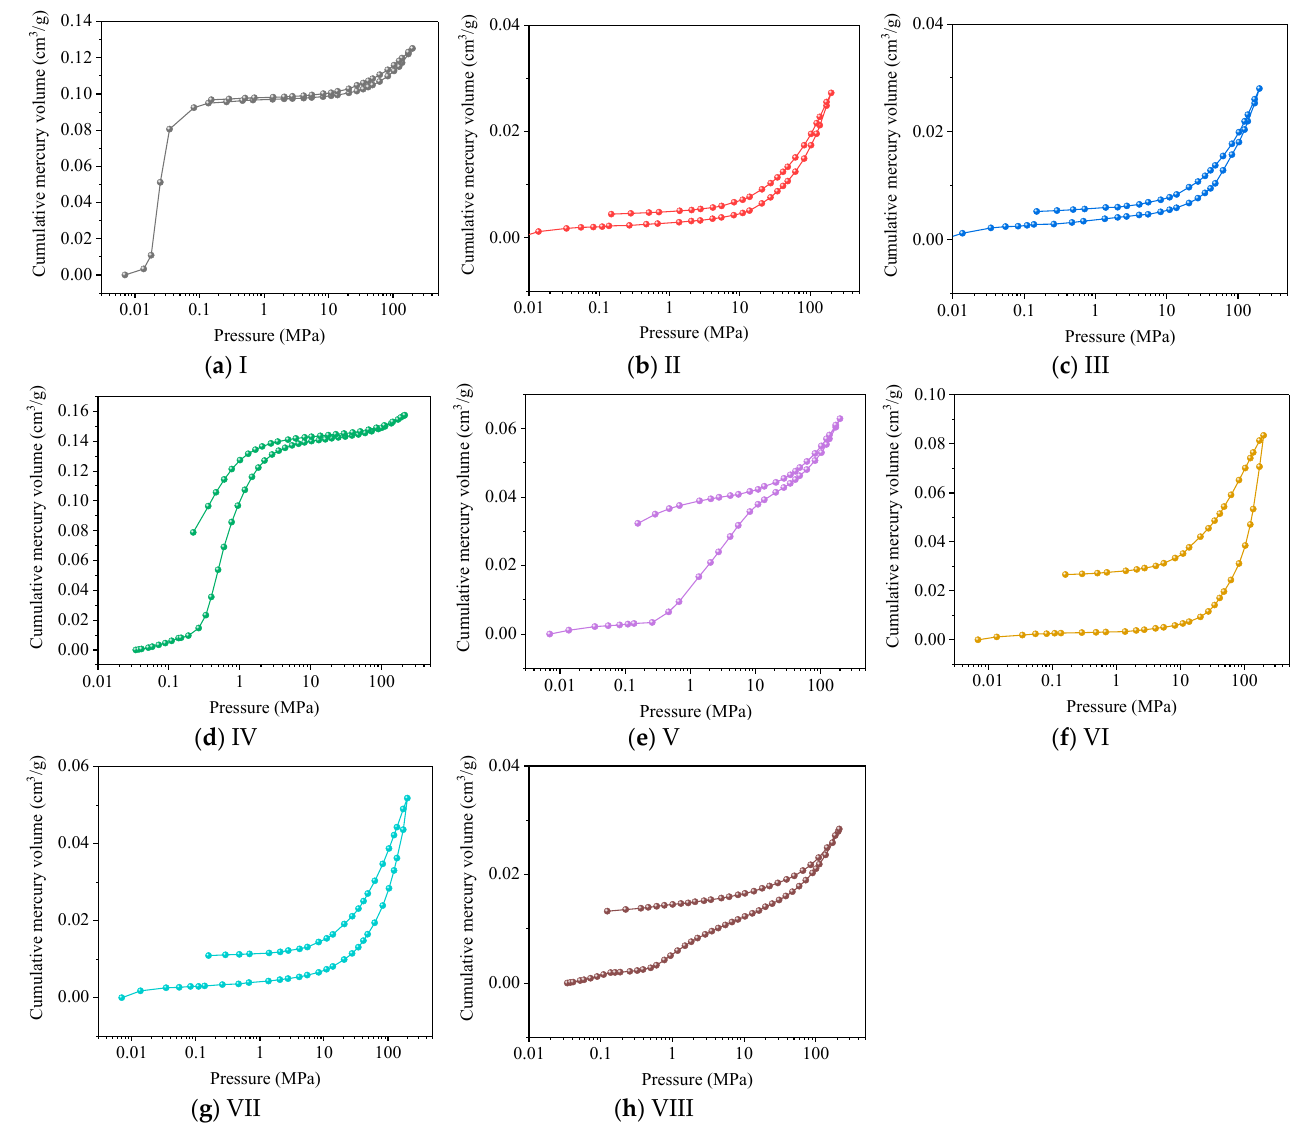
Figure 4. The mercury intrusion/extrusion curves of 8 coal samples: ( a ) Sample I; ( b ) Sample II; ( c ) Sample III; ( d ) Sample IV; ( e ) Sample V; ( f ) Sample VI; ( g ) Sample VII; ( h ) Sample VIII. The fractal dimension shows the connectivity of pores in three-dimensional microscope.